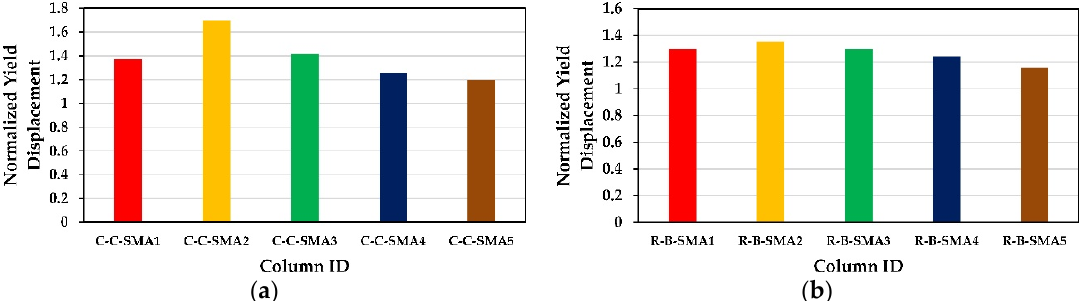
Figure 11. Normalized yield displacement: ( a ) Columns of Group1; ( b ) columns of Group2.